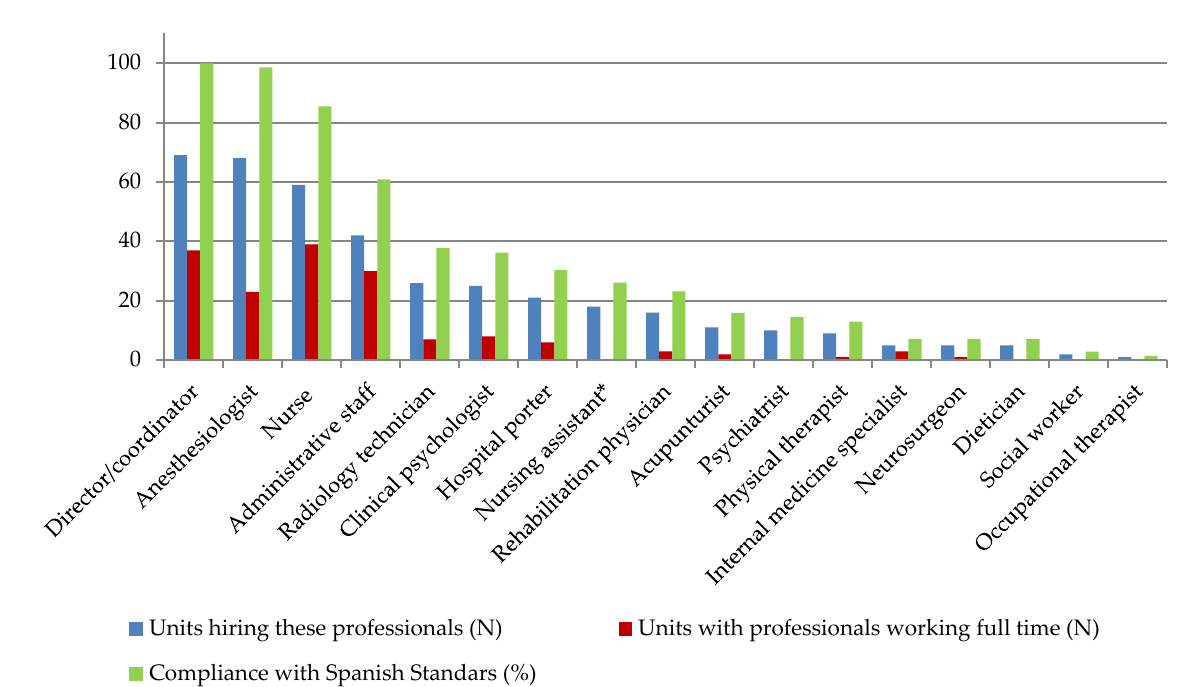
Figure 3. Availability of professionals in a sample of Spanish pain units in 2018 ( n = 69).